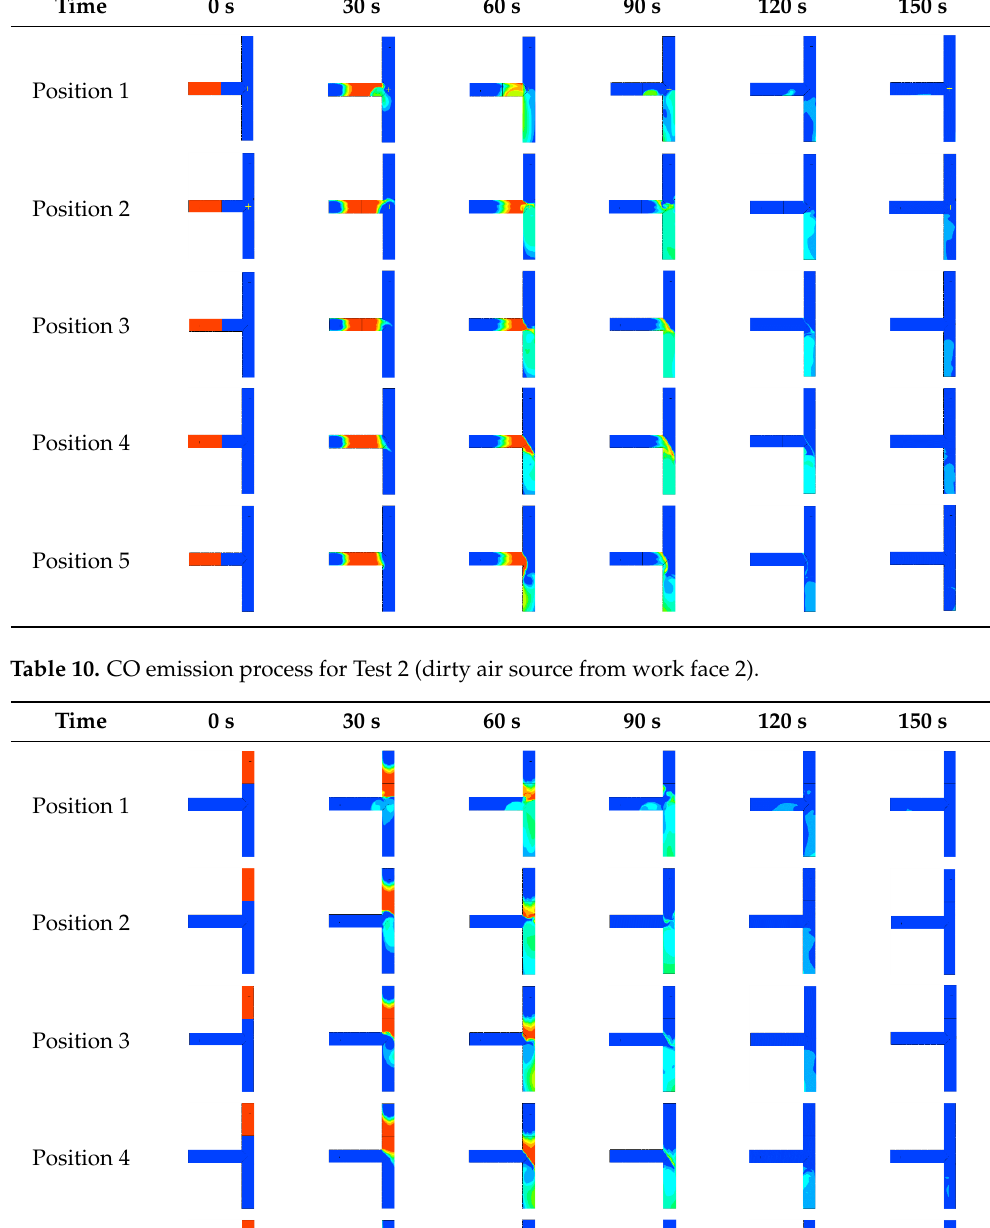
The CO emission process is shown in Tables 9 and 10. Table 9. CO emission process for Test 2 (dirty air source from work face 1). Time 0 s 30 s